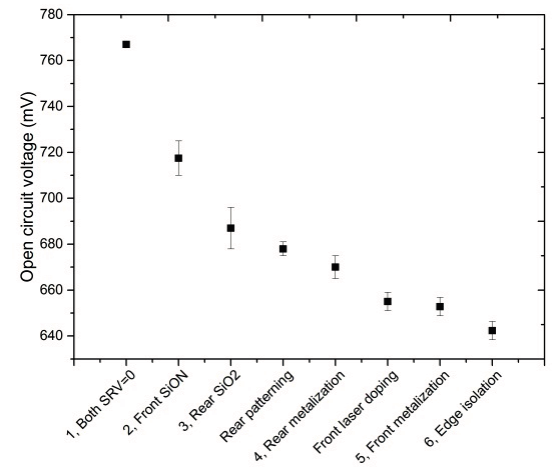
Figure 8. Summary of V oc variation during the fabrication process. The first data point was from the calculation, while the remaining data points were based on the measured results, thus with error